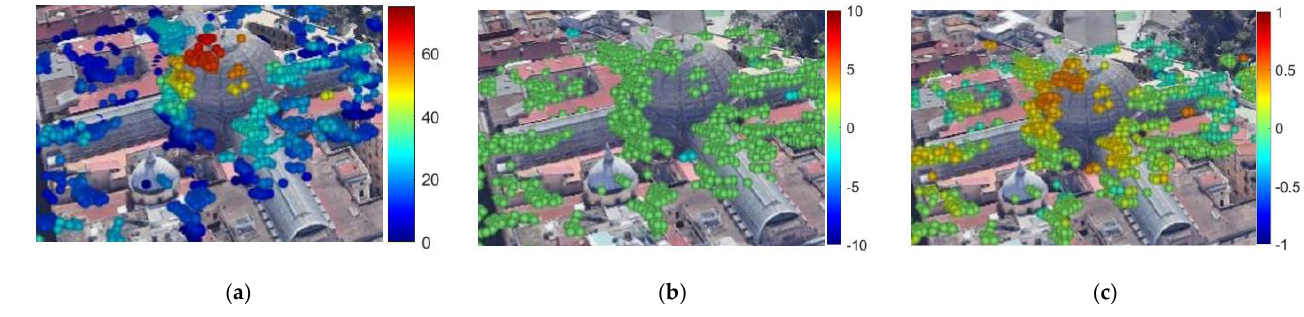
Figure 6. Galleria Umberto I test site: ( a ) points detected using MGLRT with a 3 × 3 patch, positioned in the optical 3D image, with a colorization corresponding to the height (m), ( b ) to the linear deformation velocity (mm/year), and ( c ) to the thermal dilation coefficient (mm/°C).